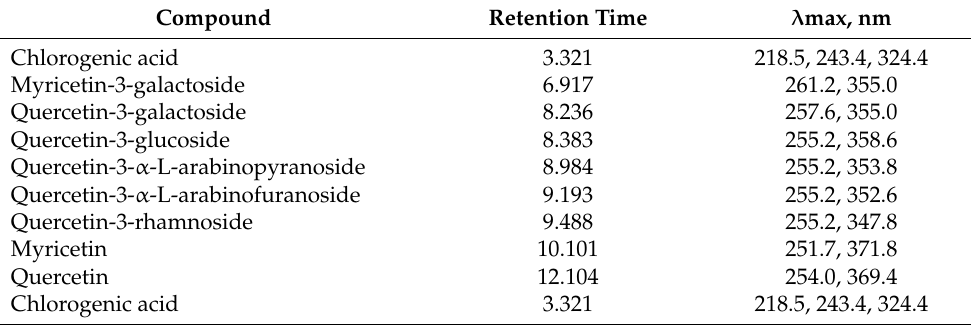
Figure 1. UPLC-DAD profile of American cranberry fruit samples at 360 nm. (1) chlorogenic acid, (2) myricetin-3-galactoside, (3) quercetin-3-galactoside, (4) quercetin-3-glucoside, (5) quercetin-3- α -L-arabinopyranoside, (6) quercetin-3- α -L-arabinofuranoside, (7) quercetin-3-rhamnoside, (8) myricetin, and (9) quercetin. Table 1. Retention times and UV-vis absorption spectral data of the identified compounds.